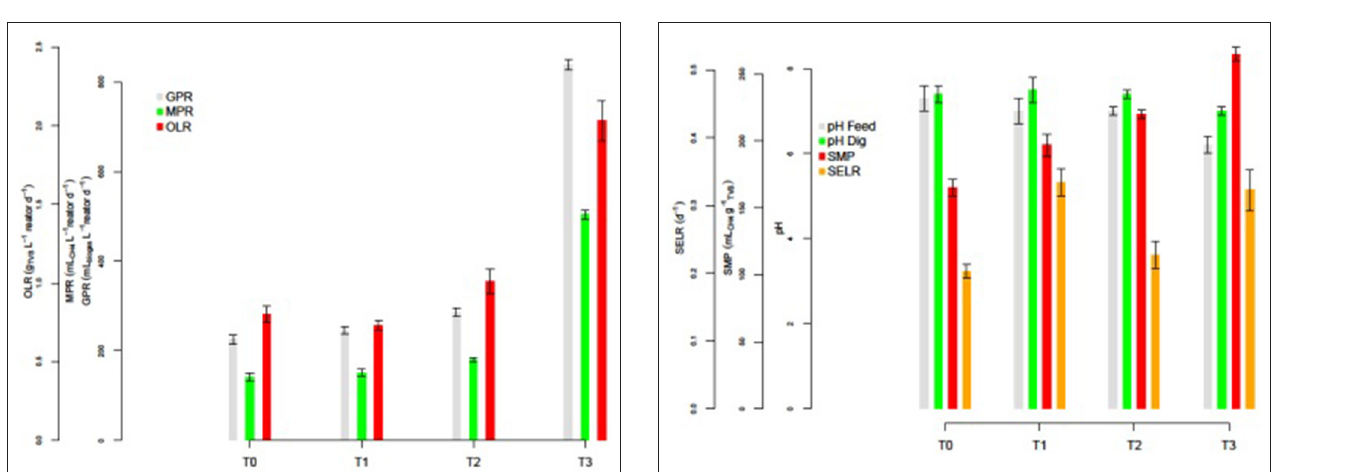
FIGURE 4 | Biogas production rate (GPR), methane production rate (MPR), and average organic loading rate (OLR) during the operational time, where AD and AcoD correspond to the first and second experimental phases: AD of PS (T0) and AcoD of PS after introduction of CECL (T1, T2, and T3).